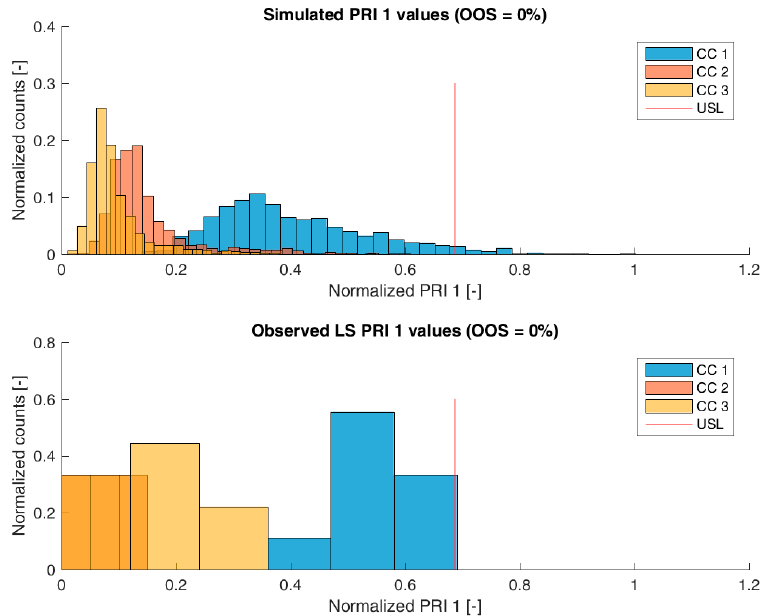
Figure 3. Comparison of simulated ( top ) product-related impurity 1 distribution and observed ( bottom ) product-related impurity 1 from LS after each column step. Normalization was performed by dividing by the maximum observed c CQA .